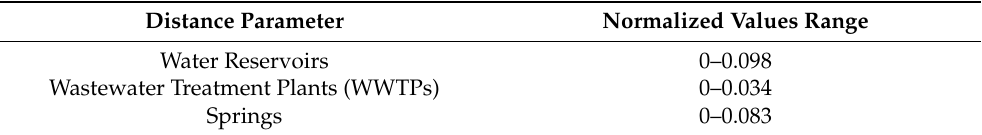
Table 5. Distance to Water Reservoirs, Wastewater Treatment Plants (WWTPs) and Springs normal- ized range of